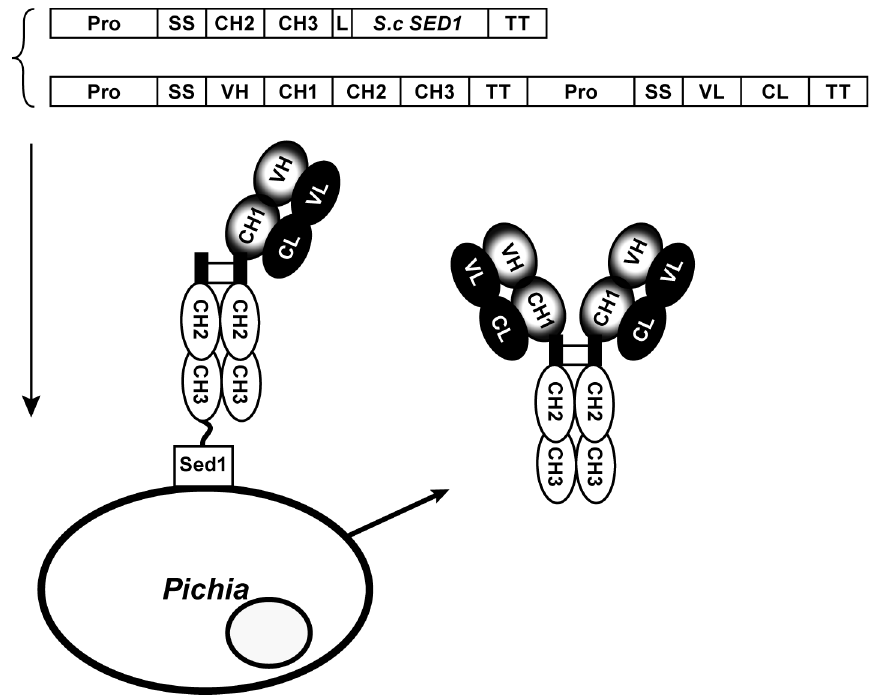
Figure 1. A schematic representation of the Fc-Sed1p antibody display system. The DNA sequence of the hinge region along with the CH2 and CH3 domains comprising the IgG Fc fragment are fused through a flexible linker to a cell wall anchoring partner, in this case the S. cerevisiae GPI anchor Sed1p is used. When co-expressed in the same host with a secretable full length IgG molecule, the Fc portion of the anchored fusion (the bait) heterodimerizes in the ER with the Fc region of the IgG molecule, forming two disulfide bridges. Since the CH1 domain of the heavy chain can still pair with the CL domain of the secreted light chain, this tripartite complex results in surface display of the monovalent (H+L) IgG molecule. Meanwhile the assembly of soluble full length IgG occurs with equal probability resulting in secretion of the bivalent (H2+L2) in the culture medium. doi: